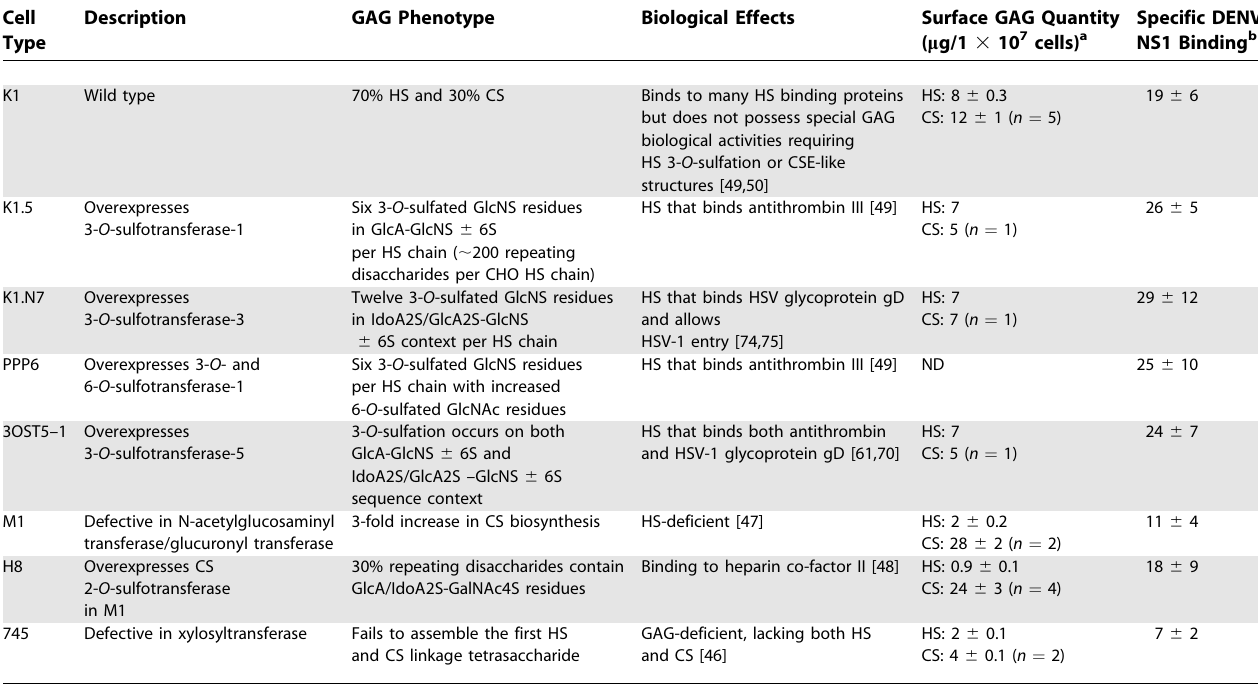
Table 2. Description of Wild Type and Mutant CHO Cells Cell